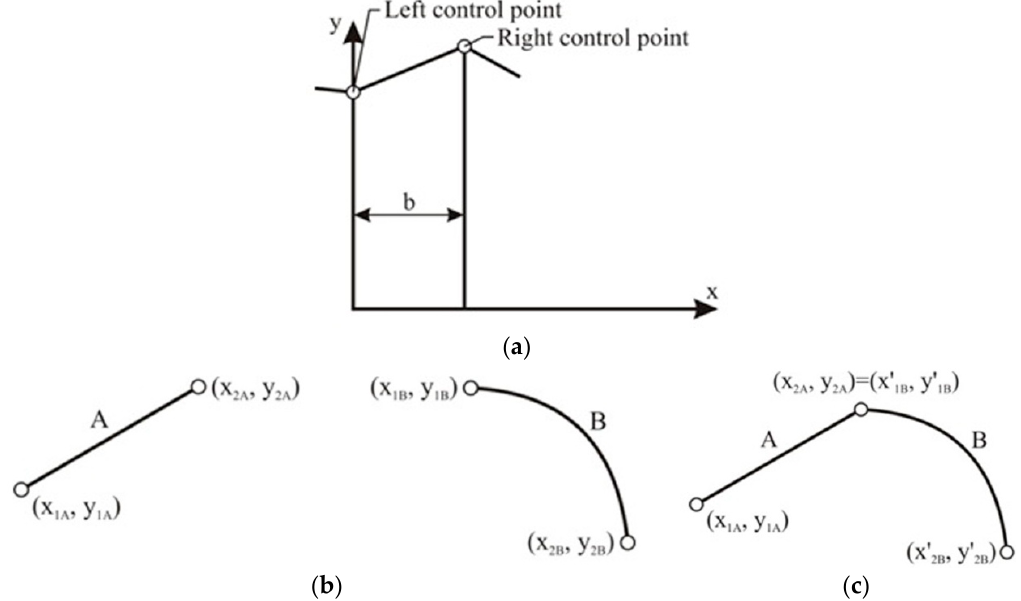
Figure 2. Concept of setting form tool: ( a ) the coordinate system of the single insert, ( b ) the control point of the example profile of two inserts, and ( c ) the cutting edge settings on a continuous multi- insert line.